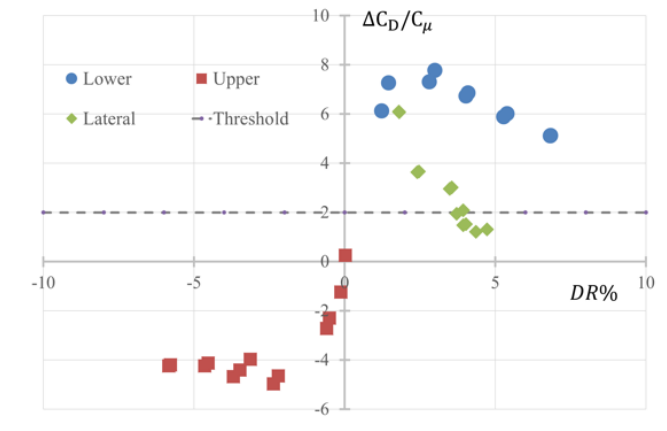
Figure 11. Wake receptivity for the single jet forcing